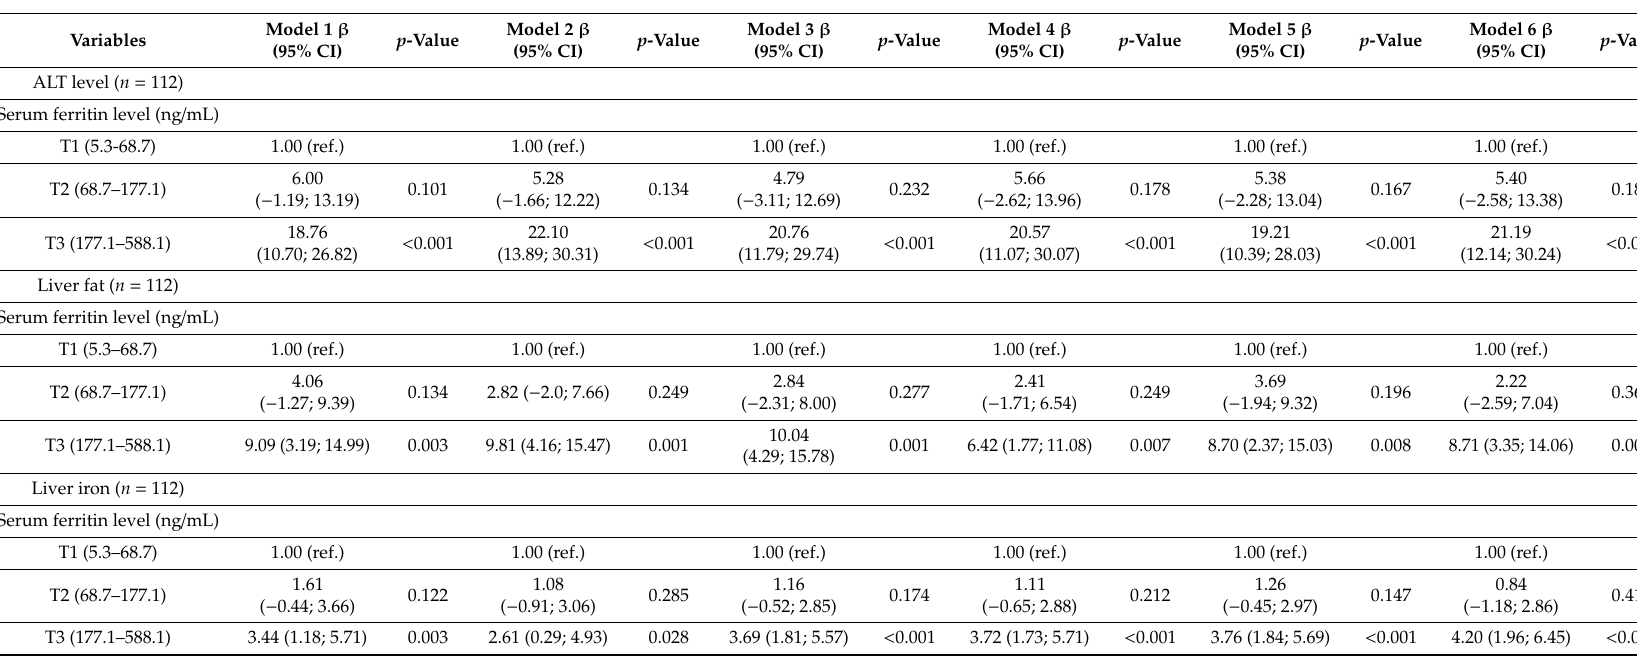
Table 3. Quantile regression models with nonalcoholic fatty liver disease (NAFLD) markers as dependent factors and serum ferritin tertiles as the independent variable among study